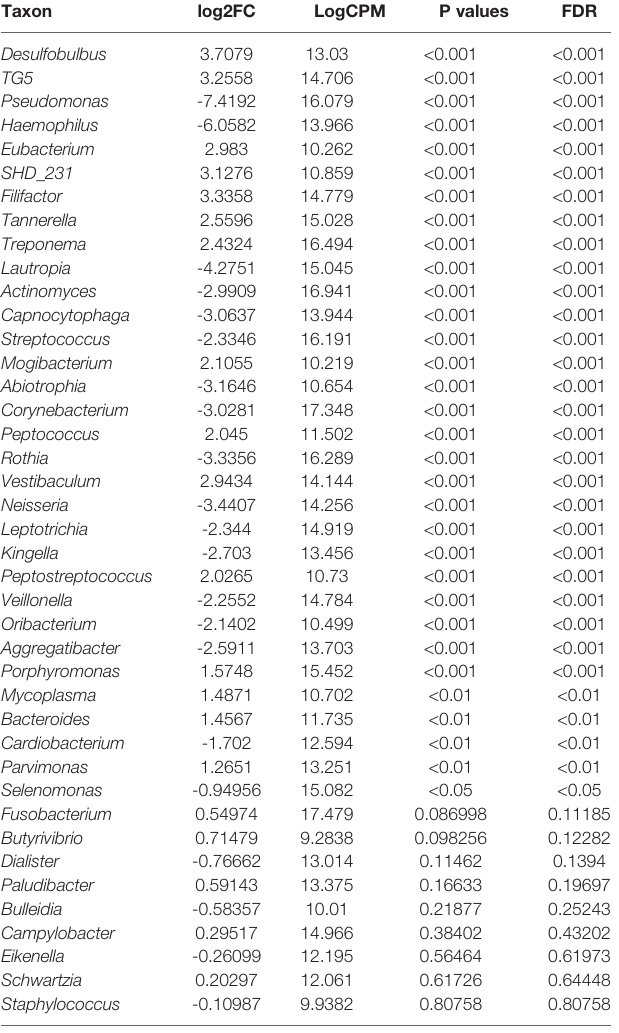
TABLE 3 | Comparison of microorganisms in the deep layer (PPD: 7 – 9 mm) and the shallow layer (PPD: 3 – 4 mm). Taxon log2FC LogCPM P values FDR